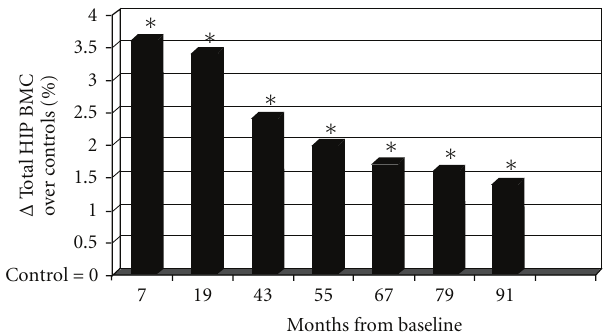
Figure 3: BMC increases more in children submitted for 7 months to a program of impact exercise (jumps) than in their control peers who had nonimpact activities. Age at onset was 8 years. Seven years after the end of the program, a small benefit of the impact activities was still detectable. Reproduced from Gunter et al. [142], with kind permission of